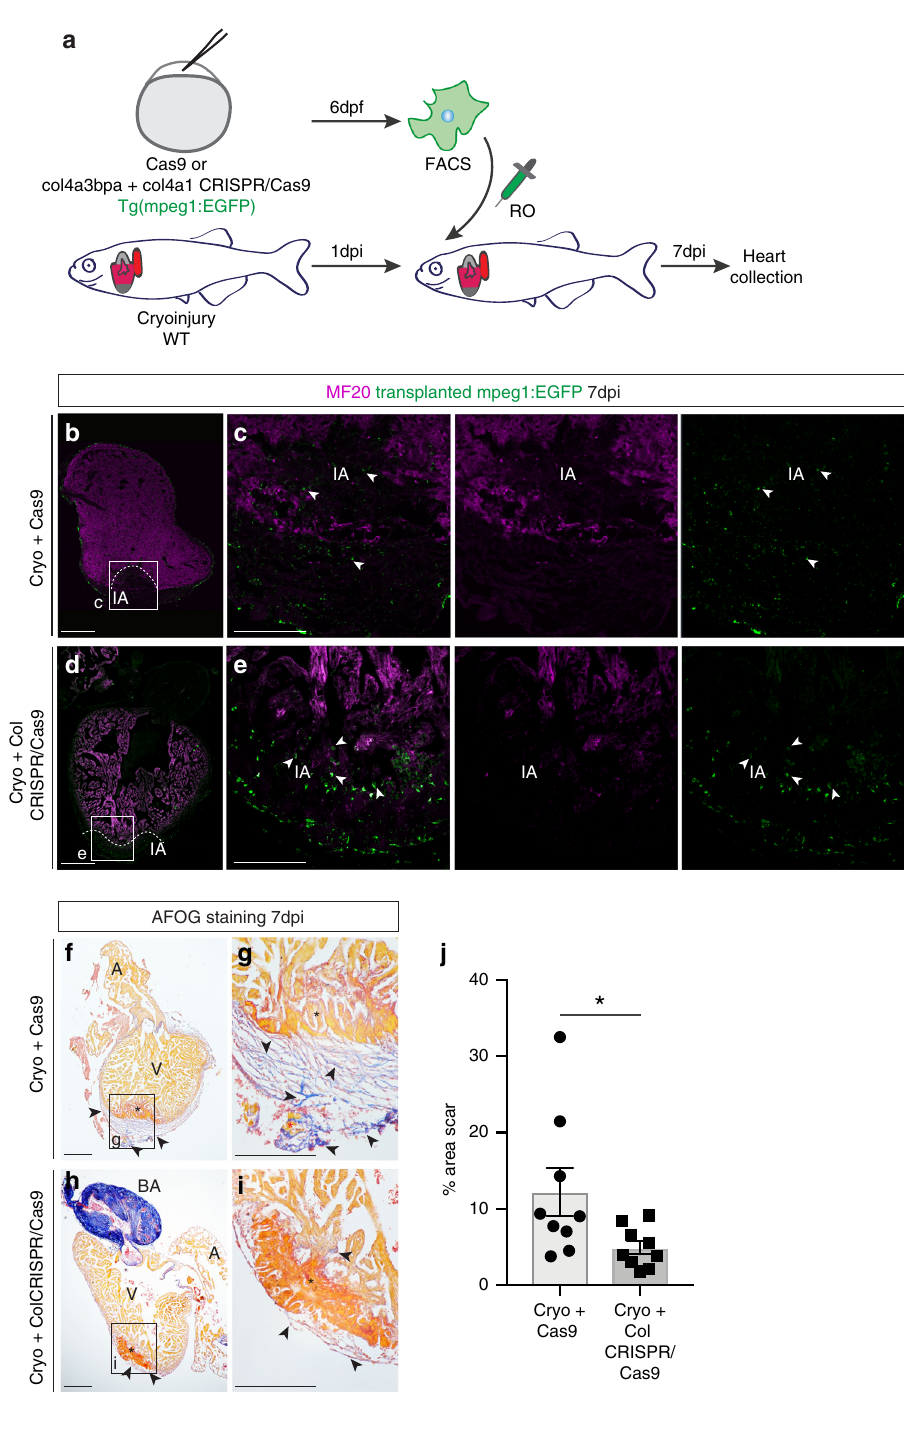
Libraries were sequenced with a MiSeq 300 cycles reagent kit (Illumina).